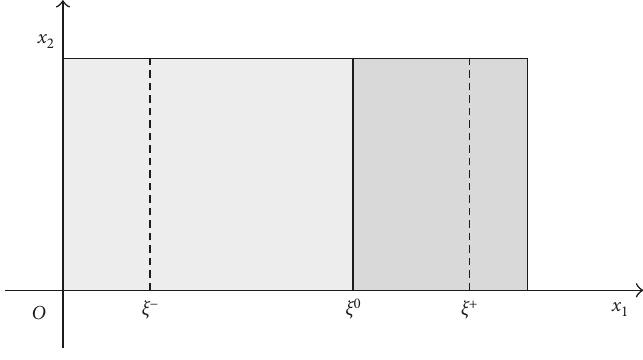
Figure 1: Domain for Poisson